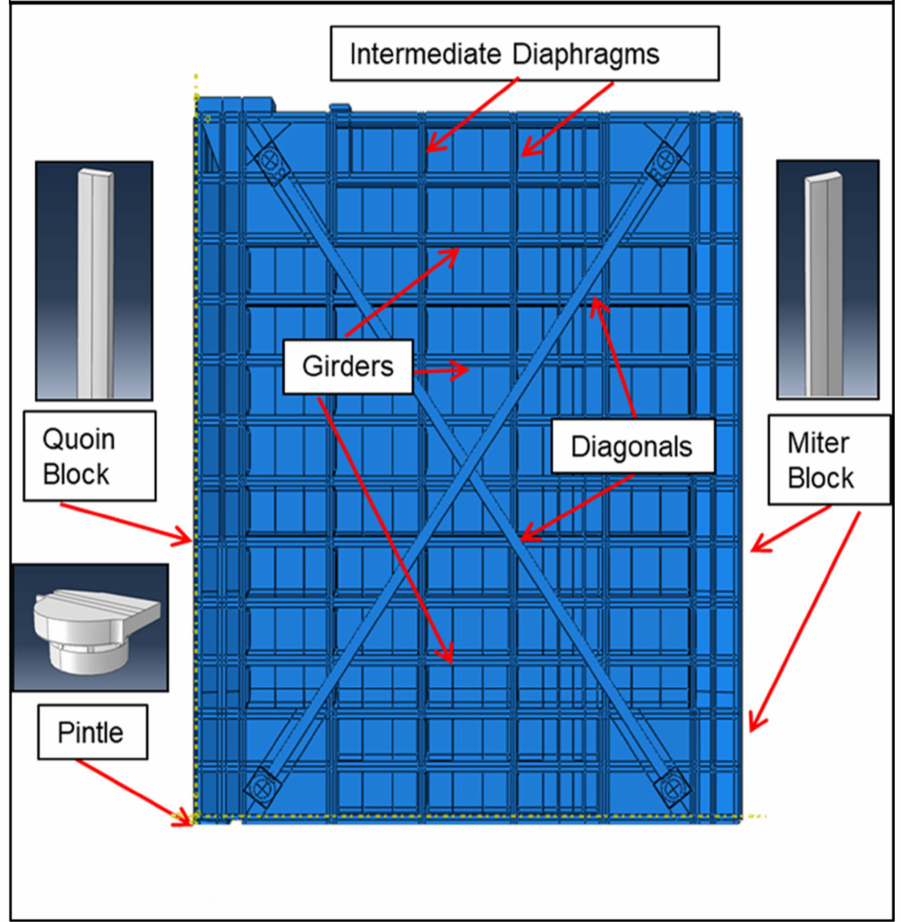
Figure 5. Downstream view of a miter gate with